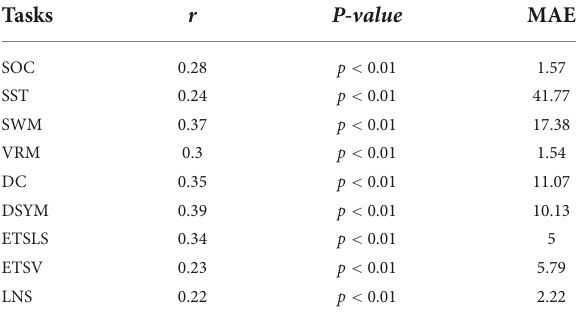
TABLE 4 Predicting cognitive functions of younger group using models based on elder